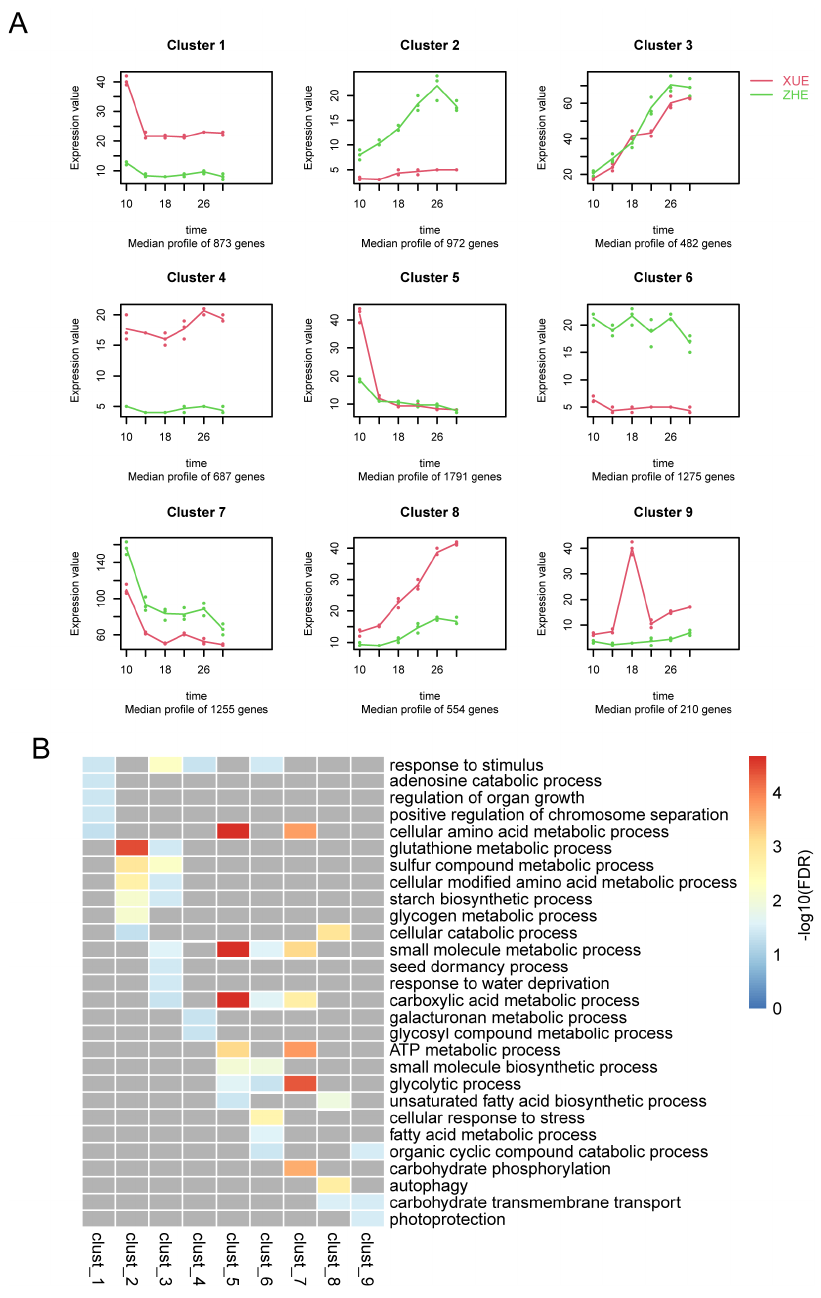
Figure 4. Time-resolved analysis of the developing kernels of Xuetian 7401 and Zhetian 11. ( A ) The DEGs were clustered according to the dynamic expression modes and ( B ) enriched in the KEGG pathways. The red lines in ( A ) reflect the expression levels of Xuetian 7401 genes, and the green ones reflect Zhetian 11 genes.